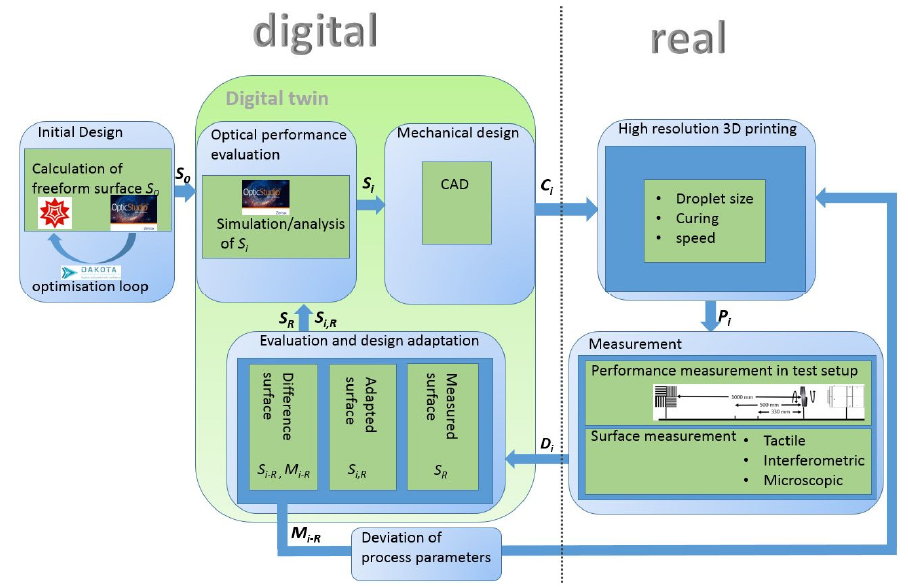
Figure 1. Digital twin and process flow.